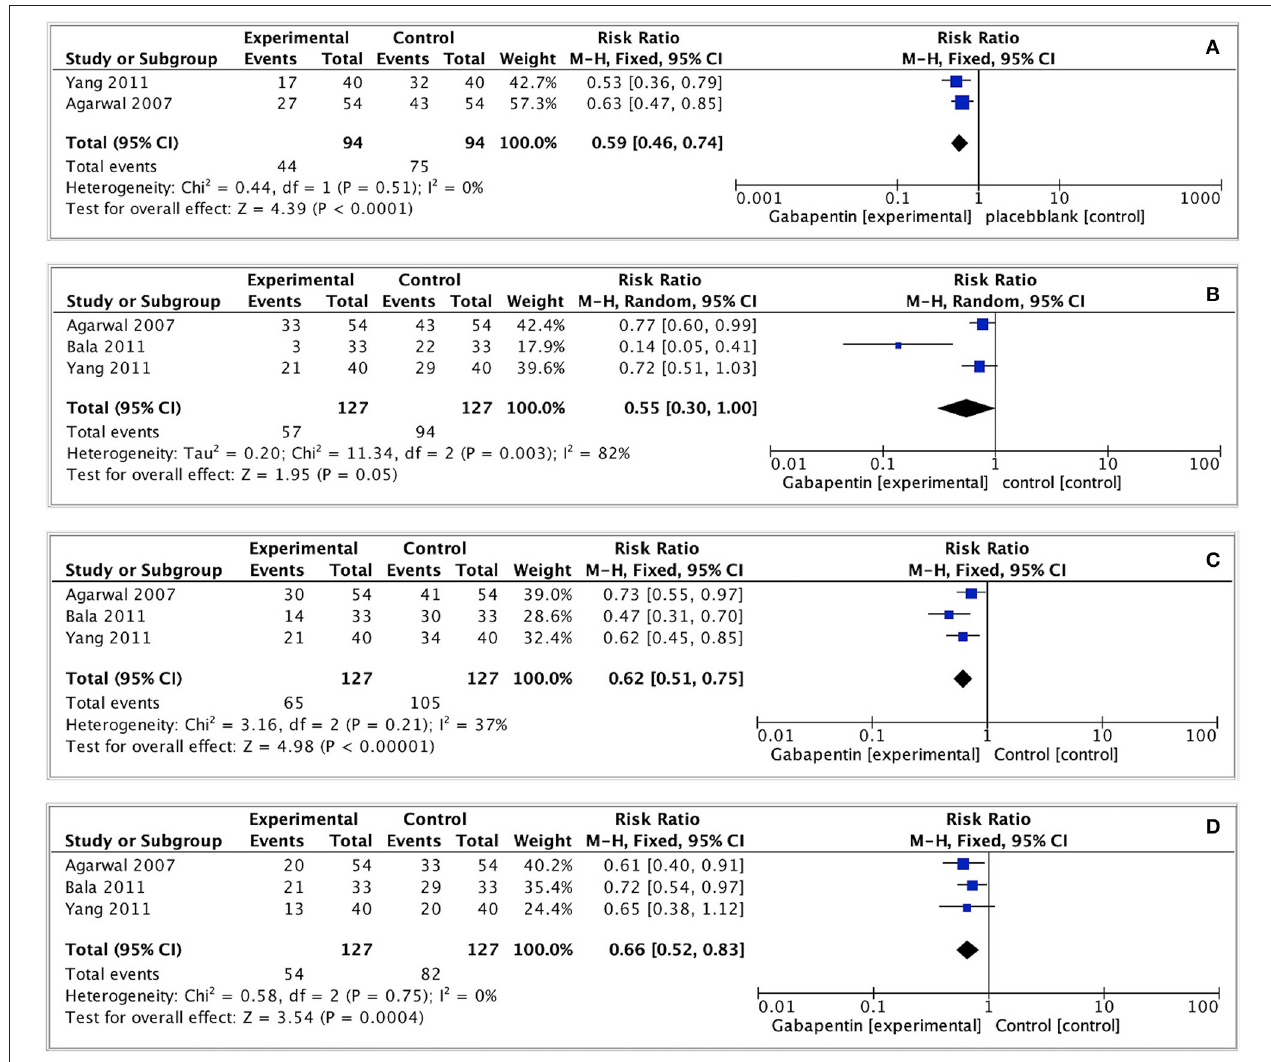
FIGURE 4 | Forest plot of any severity postoperative CRBD. (A) Any severity postoperative CRBD at 0h after surgery; (B) Any severity postoperative CRBD at 1h after surgery; (C) Any severity postoperative CRBD at 2h after surgery; (D) Any severity postoperative CRBD at 6h after surgery.